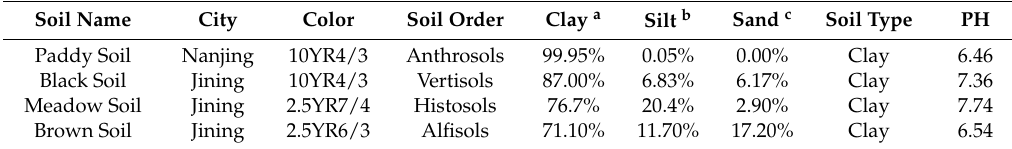
Table A1. Summary of characteristics four soils.